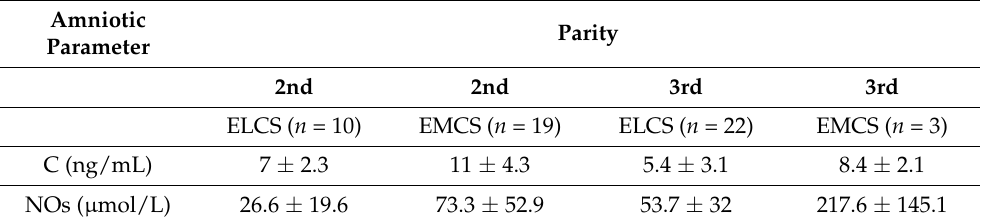
Table 4. Data (mean ± SD) about NOs and C amniotic concentrations distributed according to maternal parity in the 32 puppies delivered by elective Caesarean section (ELCS) and in the 22 puppies delivered by emergency Caesarean section